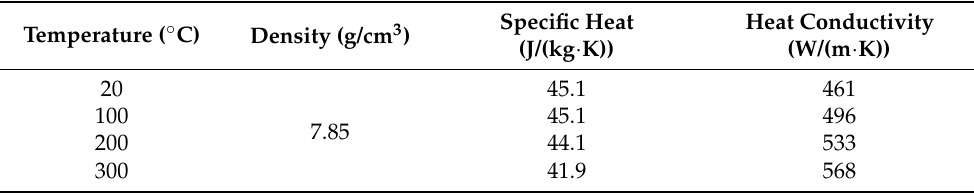
Table 3. Thermophysical properties of casting rolls.